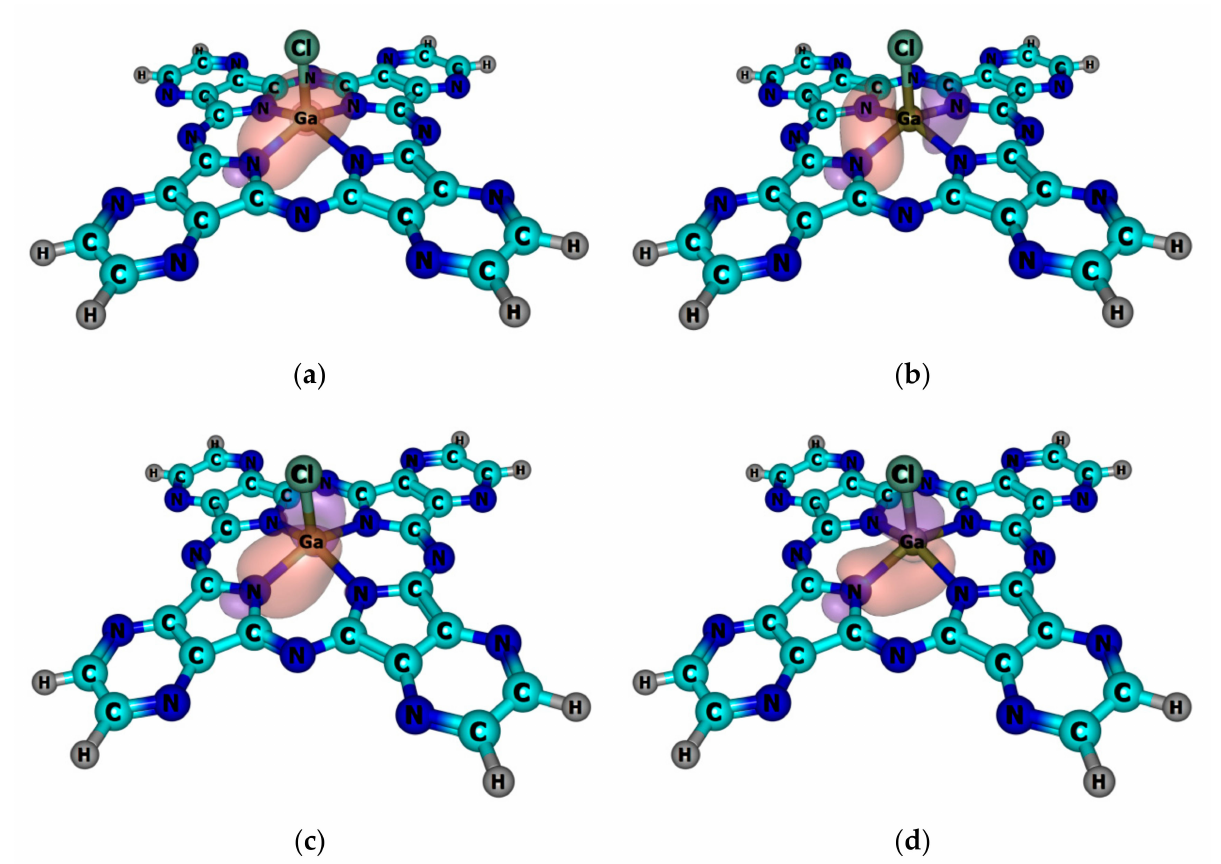
Figure 2. Schemes of the dominant donor–acceptor interactions between Ga and TPyzPA ligand. ( a ) The result of the orbital interaction of the type LP(N) → 4s(Ga) (E (2) = 59.2 kcal mol − 1 ); ( b ) the result of the orbital interaction of the type LP(N) → 4p x (Ga) (E (2) = 30.7 kcal mol − 1 ); ( c ) the result of the orbital interaction of the type LP(N) → 4p y (Ga) (E (2) = 30.7 kcal mol − 1 ); ( d ) the result of the orbital interaction of the type LP(N) → 4p z (Ga) (E (2) = 14.3 kcal mol − 1 ). Only one of the four corresponding interactions is